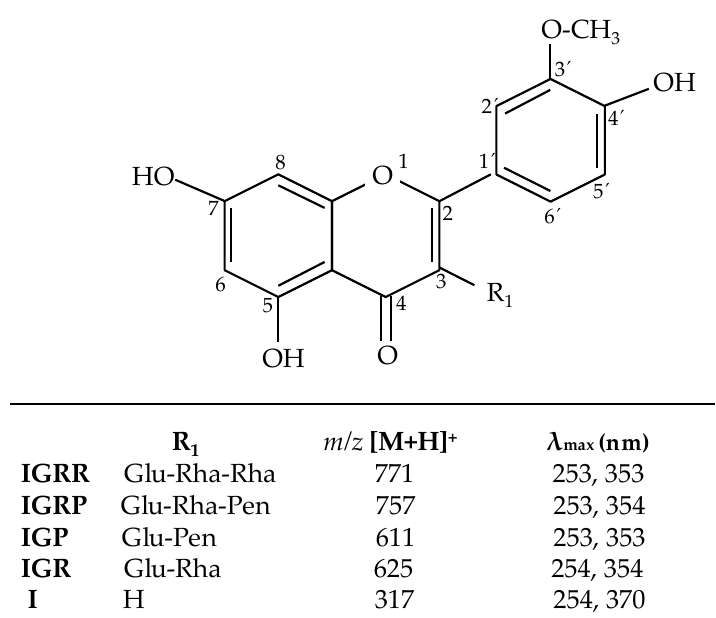
Figure 1. Chemical structures of isorhamnetin glycosides found in O. ficus-indica extract. Glc = glucose; Rha = rhamnose; Pen = pentose.